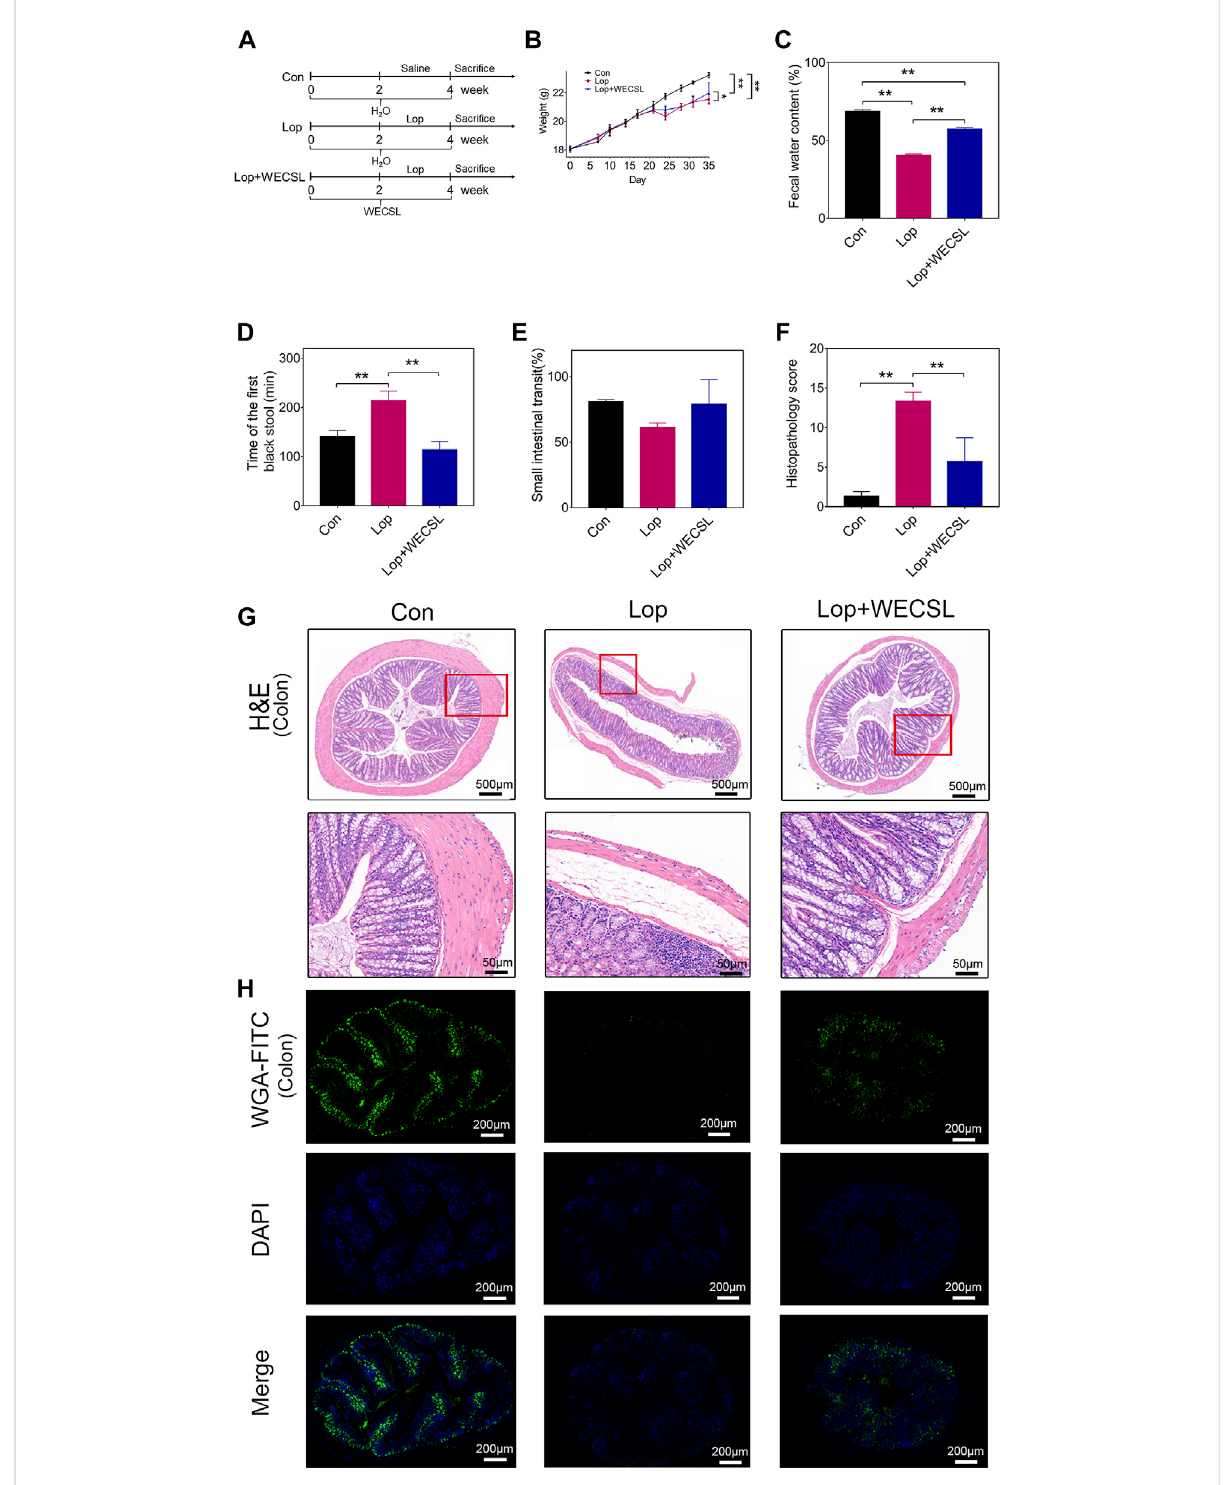
FIGURE 1 WECSL attenuated constipation symptoms in constipated mice. (A) Schematic diagram of the experimental interventions with WECSL in constipation mice ( n = 8per group). (B) Body weight (g). (C) Fecal water content. (D) Time ofthe fi rst blackstool ( n =5per group). (E) Small intestinal transit ratio (n = 3 per group). (F) Histopathology score. (G) H&E staining of the colon. (H) Mucin staining with WGA-FITC in the colon. Data are presented as mean ± SD. * p < 0.05, ** p <